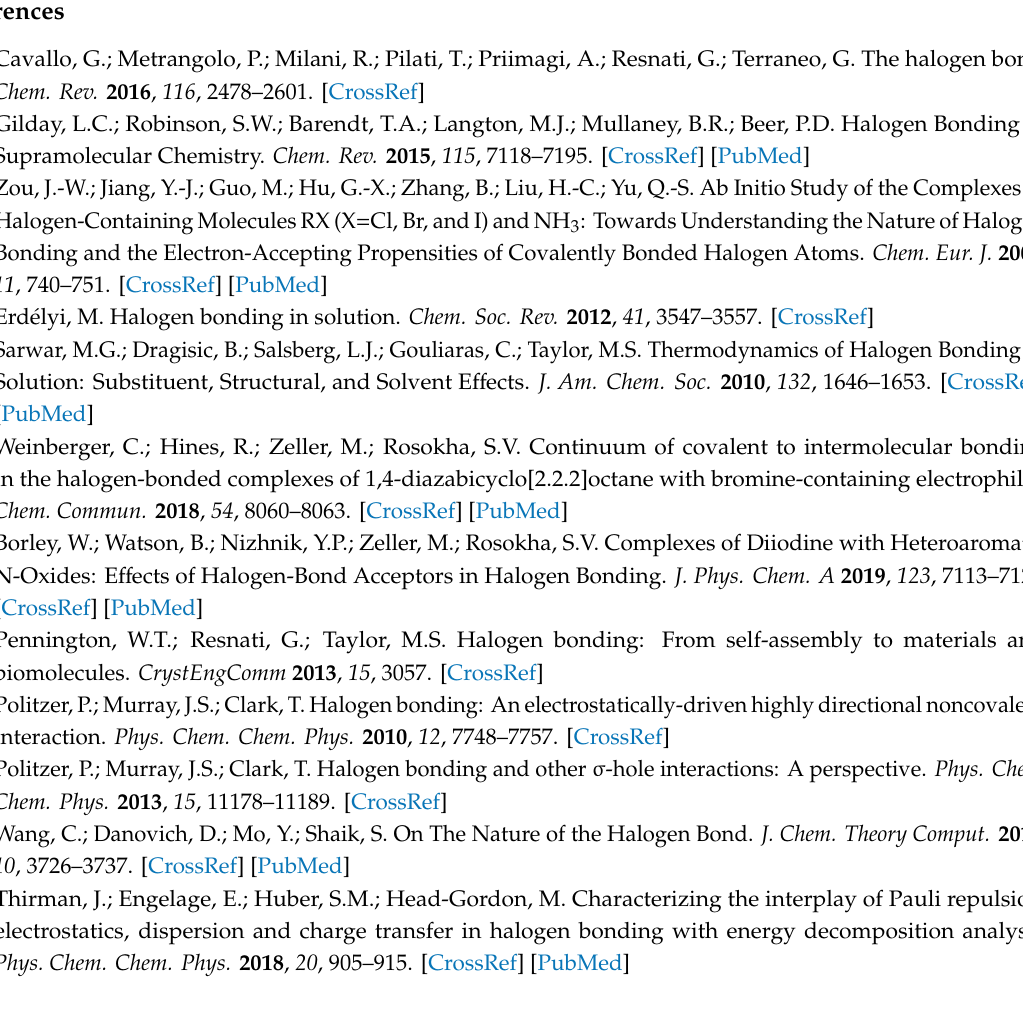
Figure S1: X-ray structure of (DABCO-CH 2 Cl)Cl · CBr 3 NO 2 . Figure S2: Correlation between calculated and experimental Br ... Cl distances. Figure S3. Correlation between calculated ∆ E and ∆ E INT . Figure S4. Correlation between calculated values of charge transfer and intermolecular distances. Table S1: Characteristics of the R–Br · Cl − complexes calculated in the gas phase. Table S2: Calculated energies of the R-Br − electrophiles and the R–Br · Cl − complexes. Table S3. Atomic coordinates of the calculated R–Br · Cl −